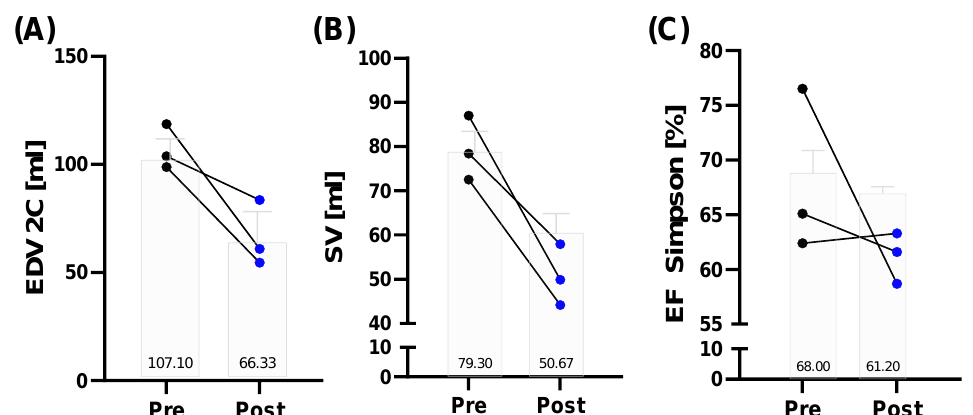
Figure 4. Selected echocardiographic data of a sub-group of the 160.9/230 km race finishers ( n = 3) before (pre) and after (post) the 160.9/230 km competition. ( A ) Left-end diastolic volume (EDV) and ( B ) the stroke volume (SV) decreased post-race in all analyzed finishers. ( C ) Ejection fraction was markedly decreased in one participant. Presented are individual changes as well as mean number values.